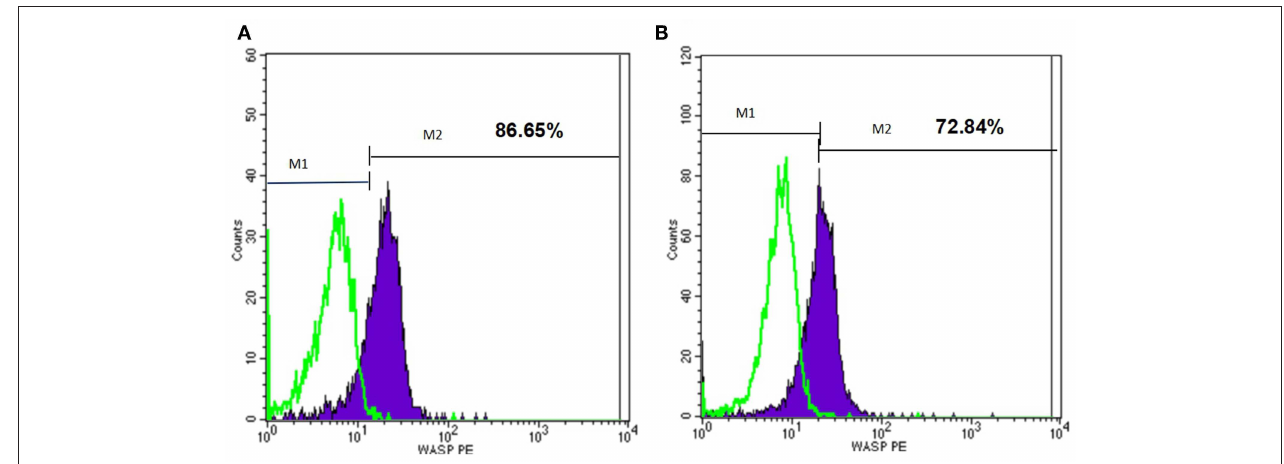
FIGURE 5 | Flow cytometry analysis of the WASp expression of one patient. M1, isotype-matched control mouse IgG2a mAb stained; M2, purified mouse anti-human WASp mAb stained. (A) WASp expression level of normal control. (B) WASp expression level of one patient (P22) with WAS gene mutation.